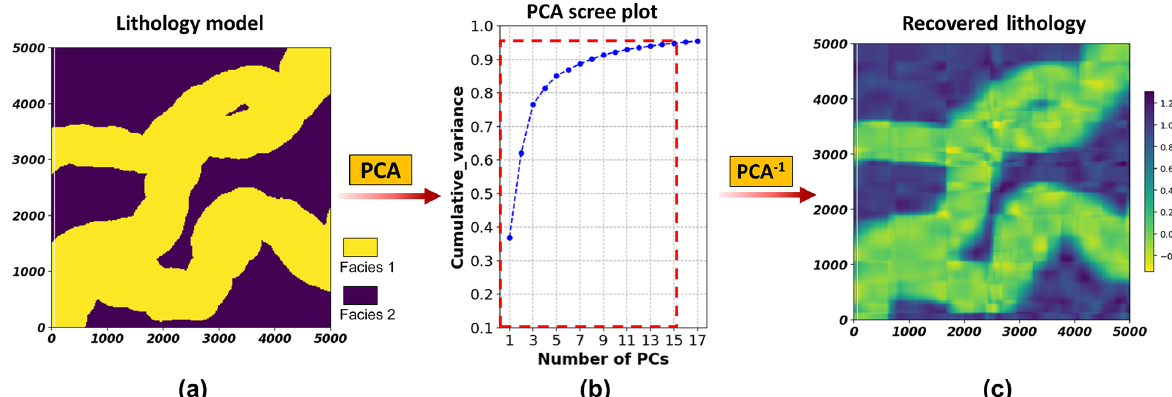
Figure 1. PCA on discrete lithology model: (a) the original lithology model; (b) scree plot of PCA on the lithology model. (c) The recon- structed model from inverse PCA using the preserved PCs (marked by the red dashed line on the scree plot).